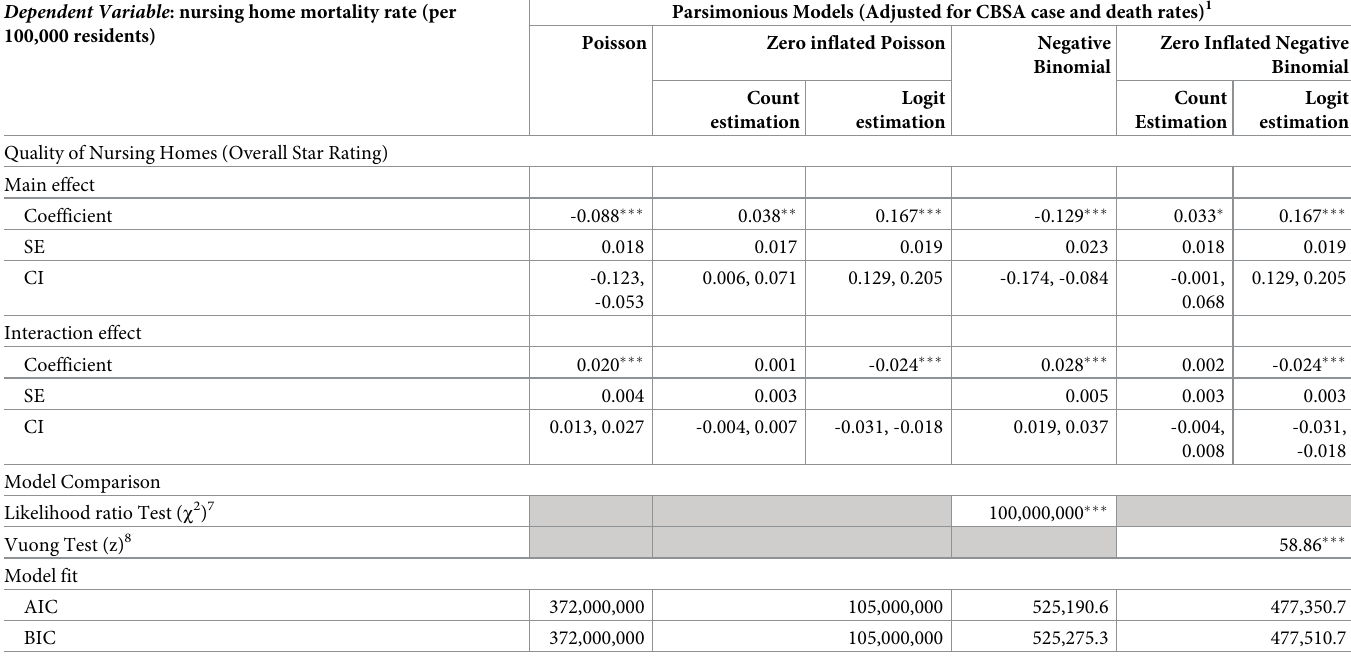
Table 2. Multivariable regression results–role of nursing home quality, parsimonious